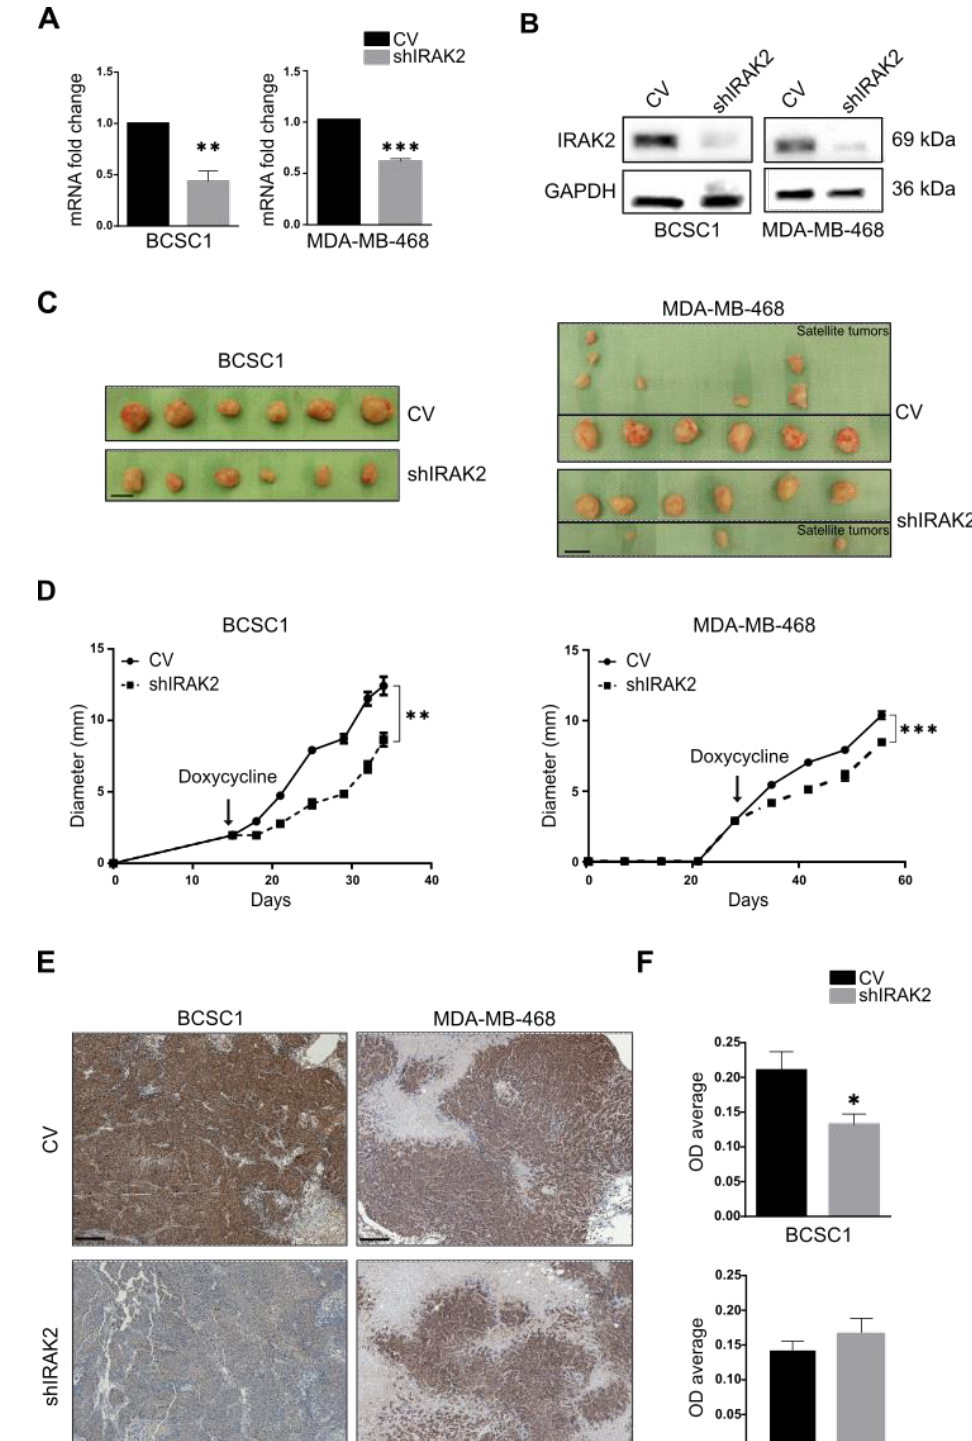
Figure 5. The ability of BCSC1 and MDA-MB-468 to form tumours is decreased by IRAK2 down- regulation. ( A ) IRAK2 expression was assessed in xenografts derived from control (CV) and IRAK2 knockdown (shIRAK2) BCSC1 or MDA-MB-468 cells at the mRNA level using qPCR. IRAK2 ex- pression was normalised to β -actin; the relative expression was calculated using the 2 −ΔΔCT method and represented as the normalised quantity of mRNA in shIRAK2 xenografts relative to the normal- ised quantity of mRNA in control xenografts, setting the control as 1. Data (n = 3) are presented as